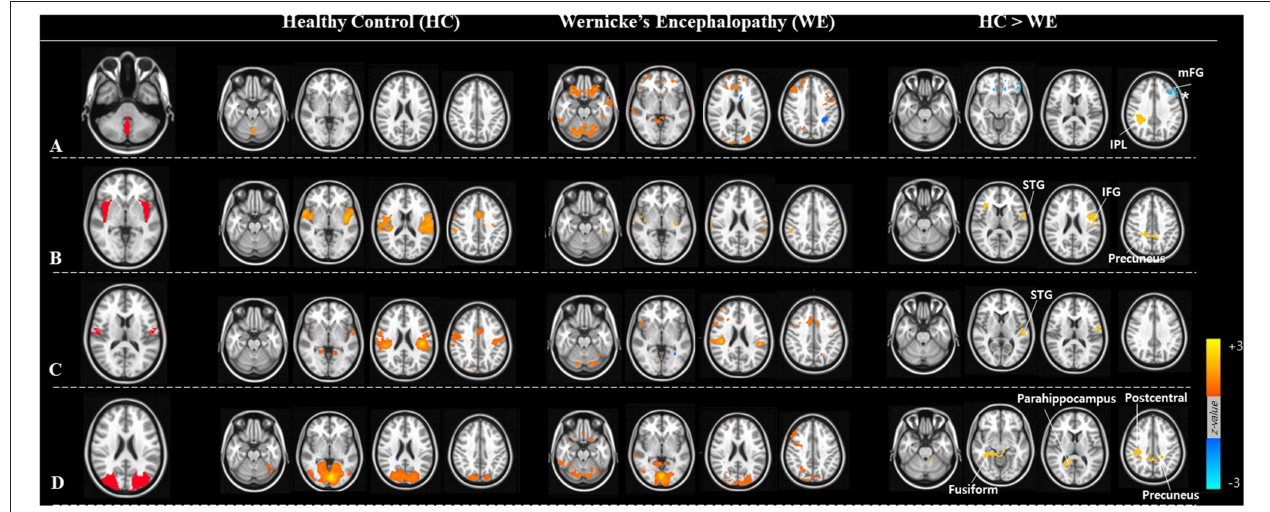
FIGURE 2 | ROIs (region of interests) and the resting-state functional connectivity analysis. Four seed regions of (A) the posterior cerebellar vermis, (B) insular cortex, (C) parietal operculum, (D) visual cortex in the left panel. Group mean resting-state connectivity with four ROI seeds in healthy control (HC) and Wernicke’s encephalopathy (WE) groups are shown in the middle panel. Subtraction of WE from HC revealed differences in functional connectivity between ROIs and other brain regions shown in the right panel.